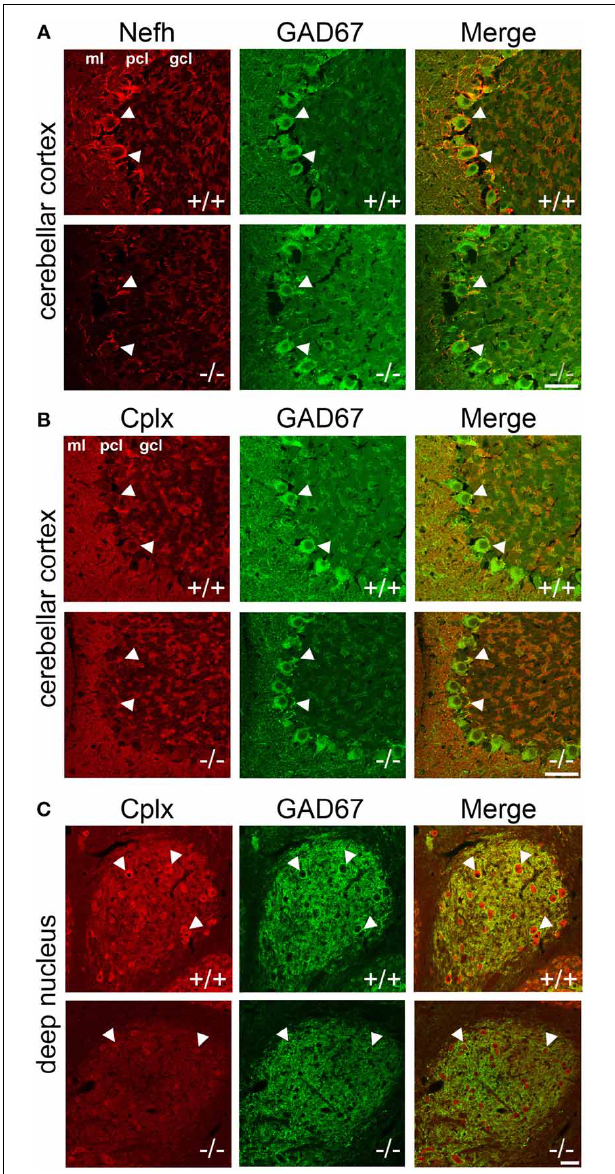
FIGURE 5 | Localization of Nefh and Cplx in PGC-1 α − / − mice. Confocal microscopy photos of immunofluorescence double-labeling of GAD67 with Nefh and Cplx1,2 reveals a differential reduction in the expression of these proteins in PGC-1 α − / − cerebellum. (A) Nefh exhibited high expression in Purkinje cell bodies (arrowheads) and dendritic processes in + / + mice. Somatic and dendritic expression was greatly reduced in the Purkinje cells of − / − animals. (B) Immunoreactivity for an antibody that recognizes both Cplx1 and Cplx2 did not reveal great expression for these proteins in Purkinje cell bodies (arrowheads), although some colocalization with GAD67-positive puncta surrounding Purkinje cells was observed in both + / + and − / − mice. (C) Cplx expression was of the greatest intensity in the deep cerebellar nuclei (interposed nucleus shown) in + / + animals. Cplx-positive cell bodies (arrowheads) were not GAD67-positive in the region, but Cplx exhibited a high degree of colocalization with GAD67-positive processes (note the high degree of GAD67 innervation of Cplx-positive cell bodies, presumably from Purkinje cell axon terminals). Cplx staining was greatly reduced in deep cerebellar nuclei of − / − animals. n = 4 − 5 /group. Scale bars = 50 μ m.